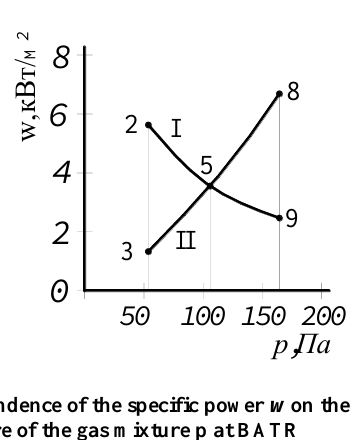
Fig. 6. Dependence of the specific power w on the pressure of the gas mixture p at BATR with autonomous saturation modes (curve I – nitriding at U = 515B = const and curve II – nitriding at j = 7.2A / m 2 = const)